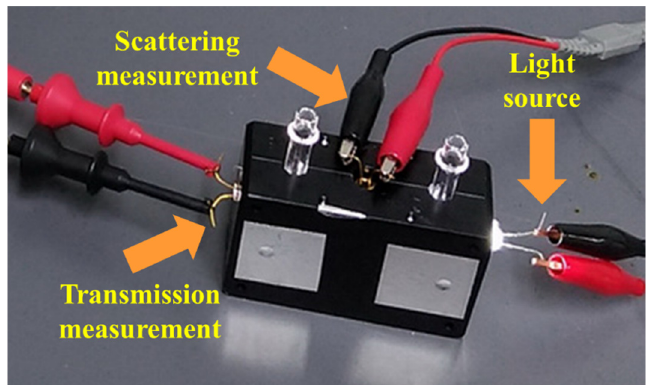
Figure 3. Prototype experimental mold of turbidity sensing module.